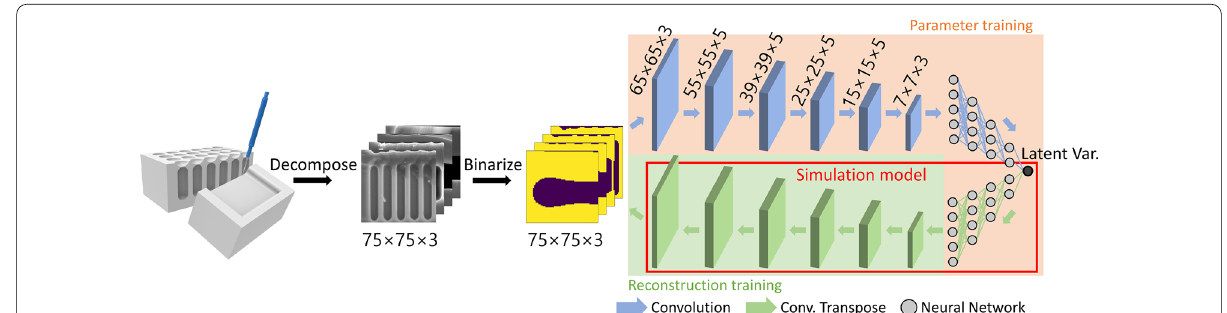
Fig. 1 Pipeline of the deep learning-based sub-surface morphology transformation simulation. The binarized SEM images of GON cross-sections are used as training data, and the deep learning architecture is trained to encode the images into single latent variable and reconstruct it into original images. The pink segment of the entire model is initially trained for parameter training, followed by selective training of green segment for the convolutional reconstruction of original training